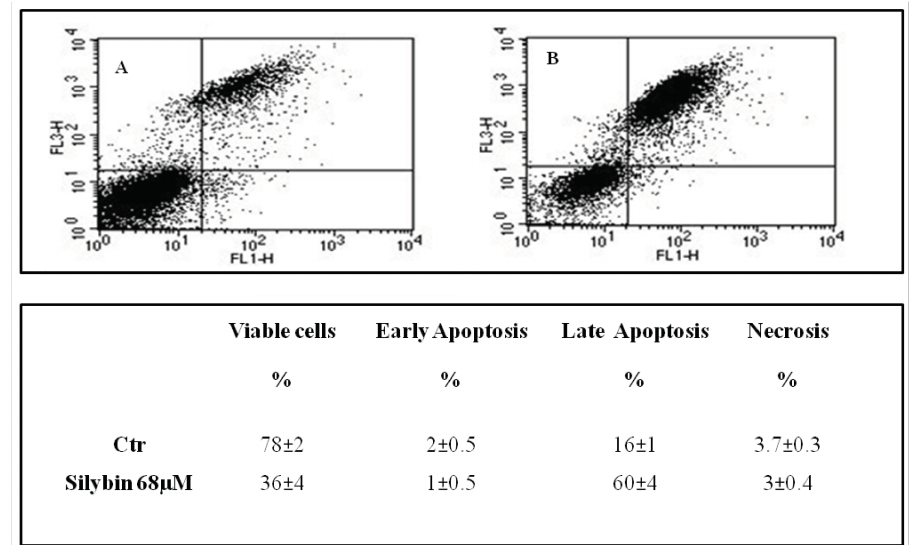
Figure 4. E ff ects of silybin on apoptosis. Apoptosis after 72 h from treatment with silybin IC50 (68 µ M) in HepG2 cells was evaluated by FACS as described in Materials and Methods. ( A ) Untreated cells (Ctr); ( B ) silybin-treated cells. Data are expressed as mean ± SD of the percentage of cells in the di ff erent phases of the cell cycle, as compared with untreated control cells.